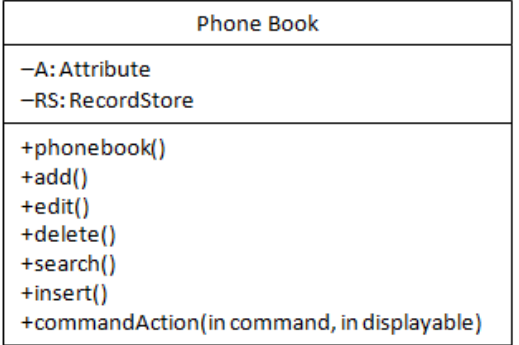
Figure 1. Integrated behavior structure for Phone Book ([40]).